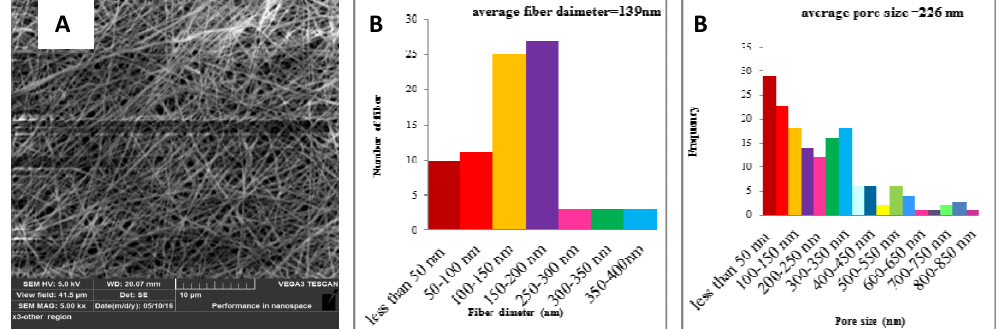
Fig. 8. (A) SEM image of pure (Nylon 6) nanofibers membrane, (B) diameter distribution and (C) pore size distribution.